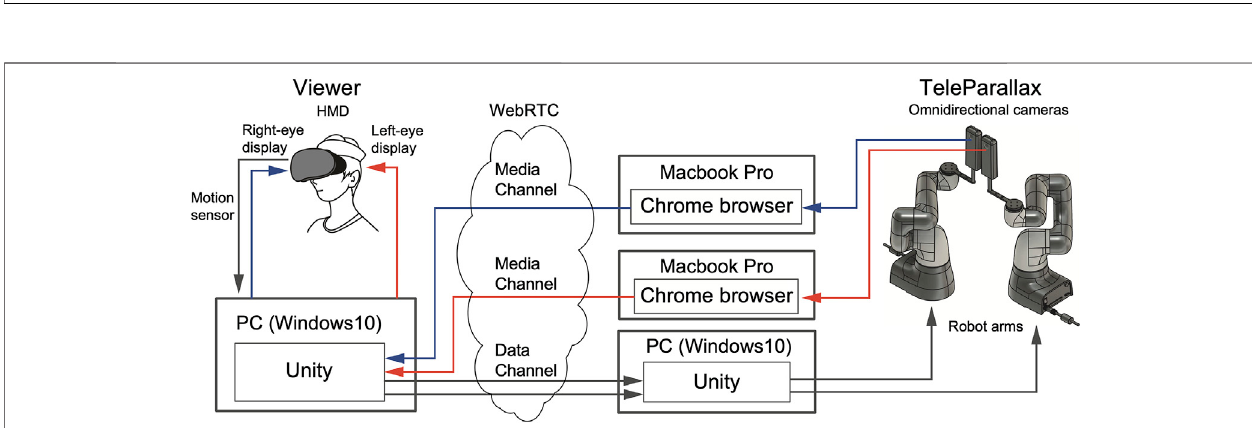
FIGURE3| Topviewofconventionalside-by-sideomnidirectionalcameras (A – C) andoursystem (D – F) .For fi xedside-by-sideomnidirectionalcameras,apparent IPD changes from normal (A) to less than normal (B) , and fi nally toalmostzero (C) asthe targetobject moves to the left. In contrast, the orientation ofthe baselineof the twoside-by-sideomnidirectionalcamera camerasinoursystemchangesaccordingtothetargetpositionwhilethelensdirectionremains unchanged. Theapparent IPD is identical for situations (D – F) .